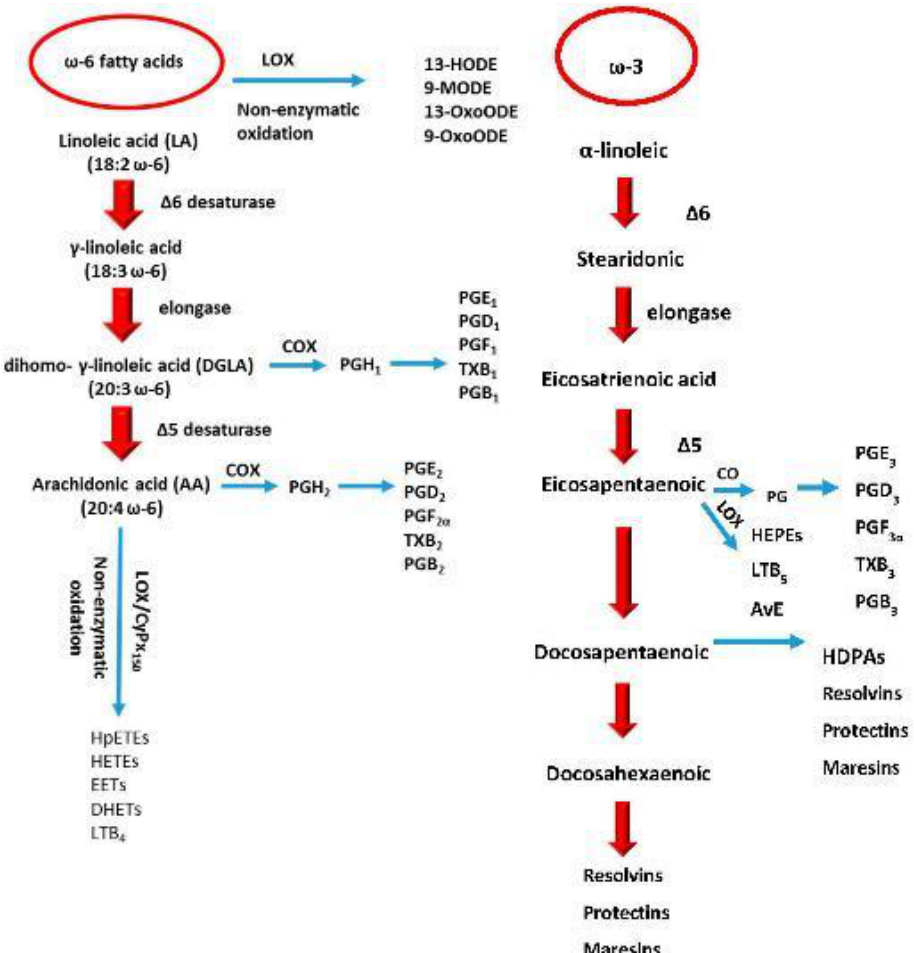
Figure 3. Schematic overview of ω -3 and ω -6 PUFA-derived lipid mediators. Adopted, with permission, from [35]. Copyright 2014, Springer International Publishing, AG.